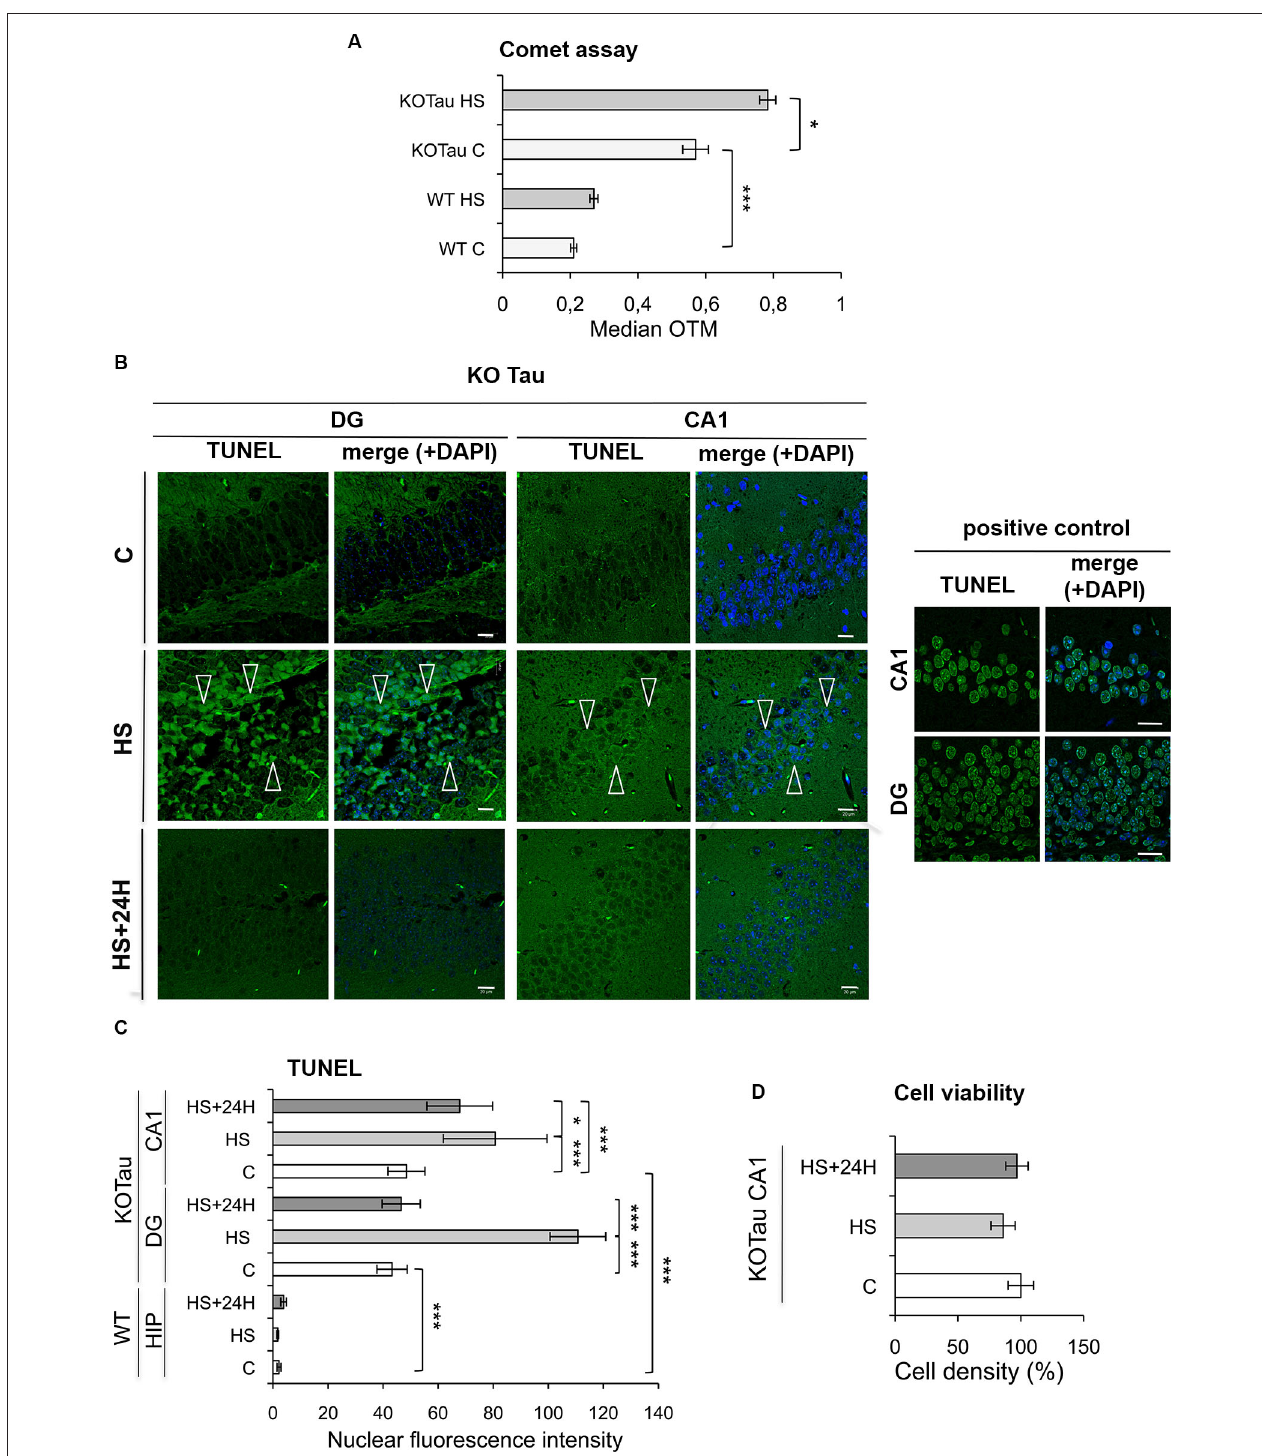
Each OTM value is the median value of 150–200 cells from three different cortices. *** p < 0.001; * p < 0.05. (B) Representative images of the dentate gyrus (DG) and CA1 sagittal sections from 7-month-old KO-Tau mice subjected to TUNEL assay under C, HS and 24 h recovery after HS (HS+24 h) conditions and analyzed using laser scanning confocal microscopy. Nuclei ( Continued